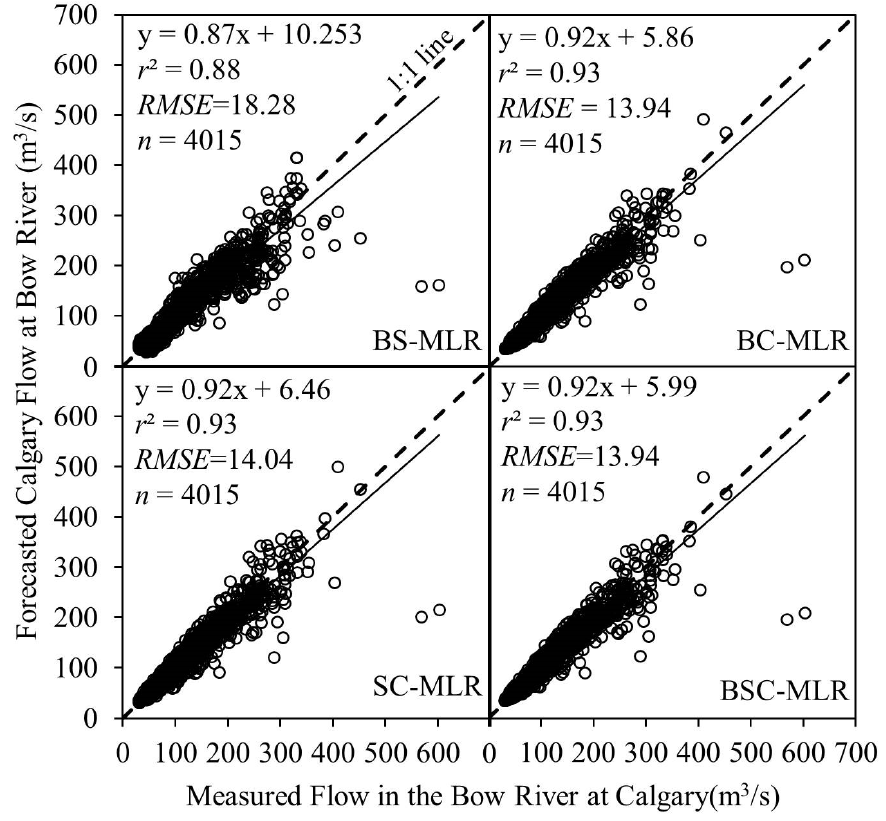
Figure 6. Comparisons between observed flow at Calgary gauge station and predicted flow using multiple linear regression models, i.e ., BS-MLR, BC-MLR, SC-MLR, and BSC-MLR in model validation